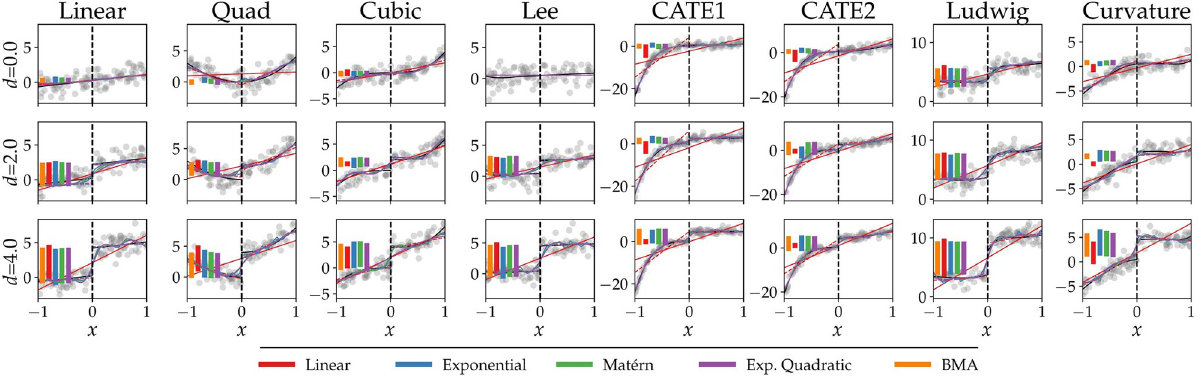
Fig 1. Regression discontinuity example. One simulation run for effect sizes d 2 {0.25, 1.0, 4.0} and σ = 1.0. The covariance functions used here are linear, exponential, Mate´rn ( ν = 3/2) and exponentiated-quadratic. The vertical bars indicate the estimated effect sizes by the discontinuous models for the different covariance functions. As the figure shows, the linear covariance function tends to have the strongest bias, in particular in the low signal-to- noise regime.